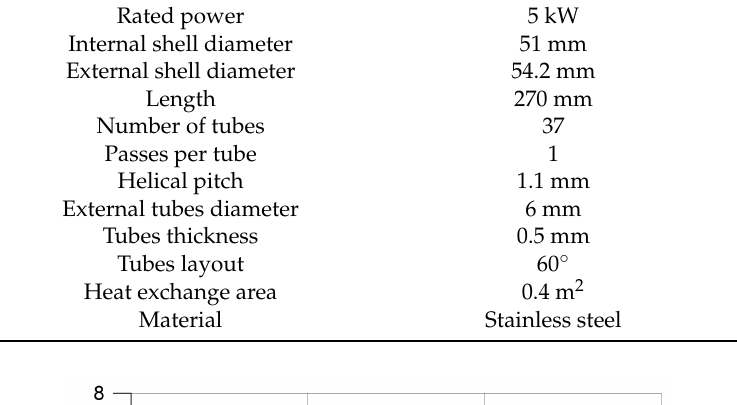
Table 2. Waste Heat Recovery (WHR)-to-oil heat exchanger specs.